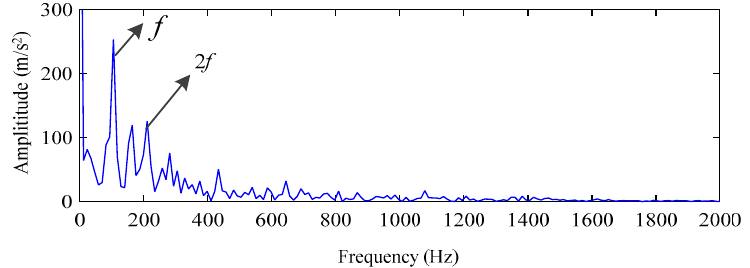
Figure 24. The envelope spectrum of the optimal component for outer ring defect by using EEMD.